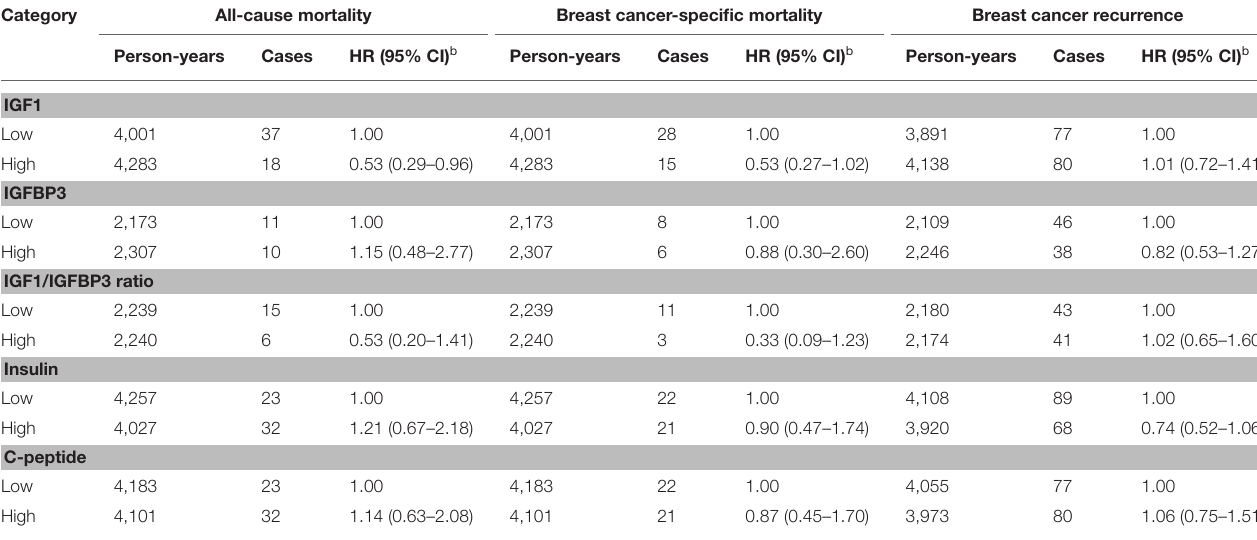
TABLE 2 | Associations of biomarkers of insulin and IGF axis with all-cause mortality, breast cancer-specific mortality, and breast cancer recurrence a . Category All-cause mortality Breast cancer-specific